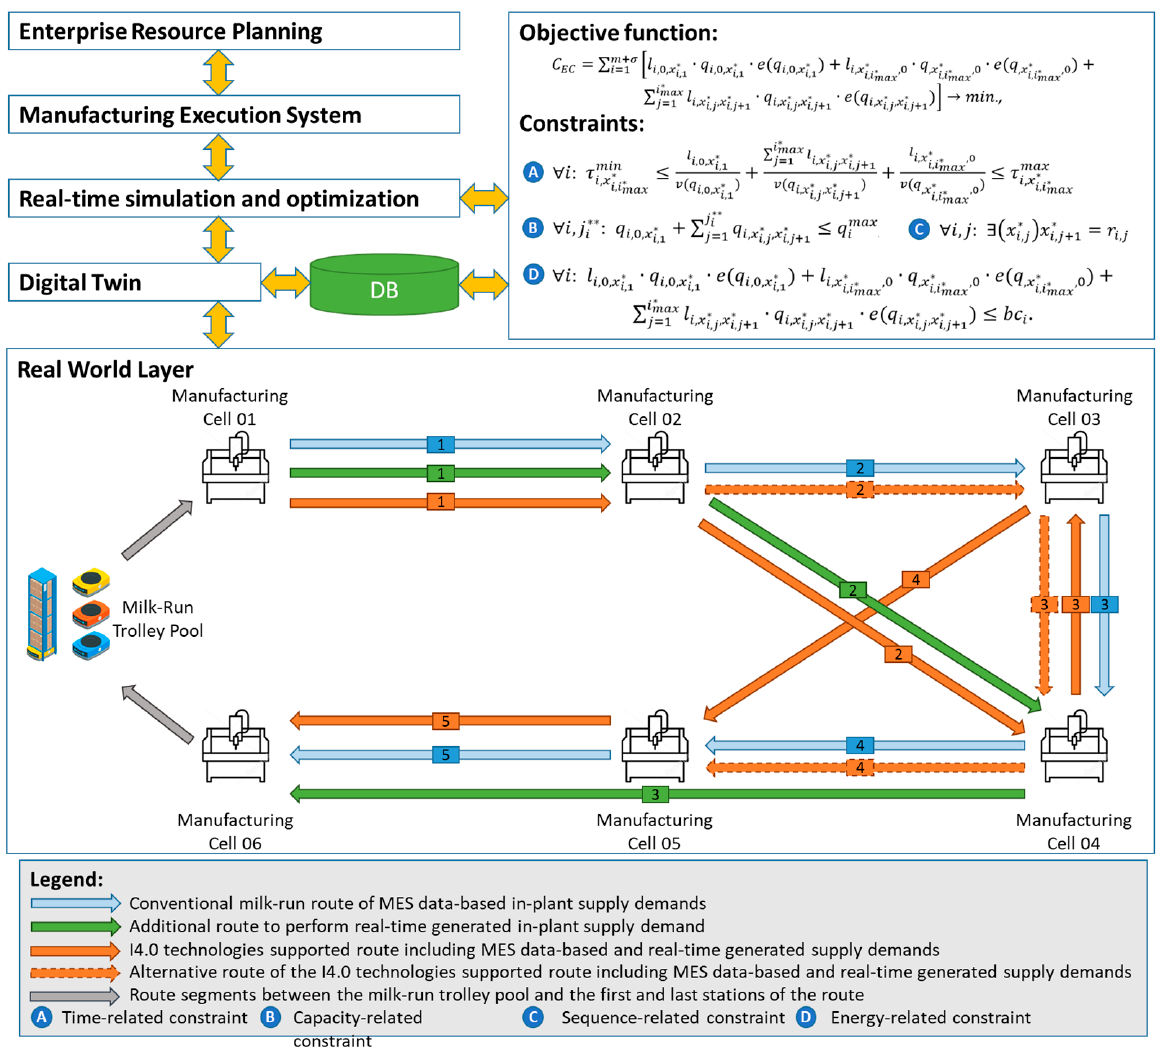
Figure 2. Optimization model of the I4.0 technologies supported real-time milk-run-based in-plant supply model.